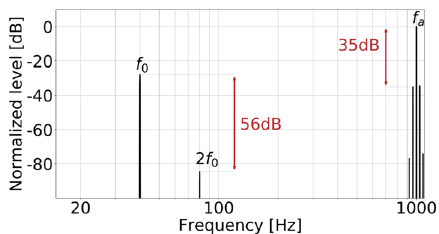
Figure 5. Amplitude spectrum of the acoustic pressure for a piston velocity signal composed of a low-frequency tone at f 0 ¼ 40 Hz and a high-frequency tone at f a ¼ 1 kHz. Intermod- ulation distortion is visible around f a , together with a slight harmonic distortion at 2 f 0 Figure 6. Time domain signal p ð z ¼ 1 ; t Þ . A time shift of the acoustic pressure (solid line) is observed, compared to the case without Doppler (dashed line).